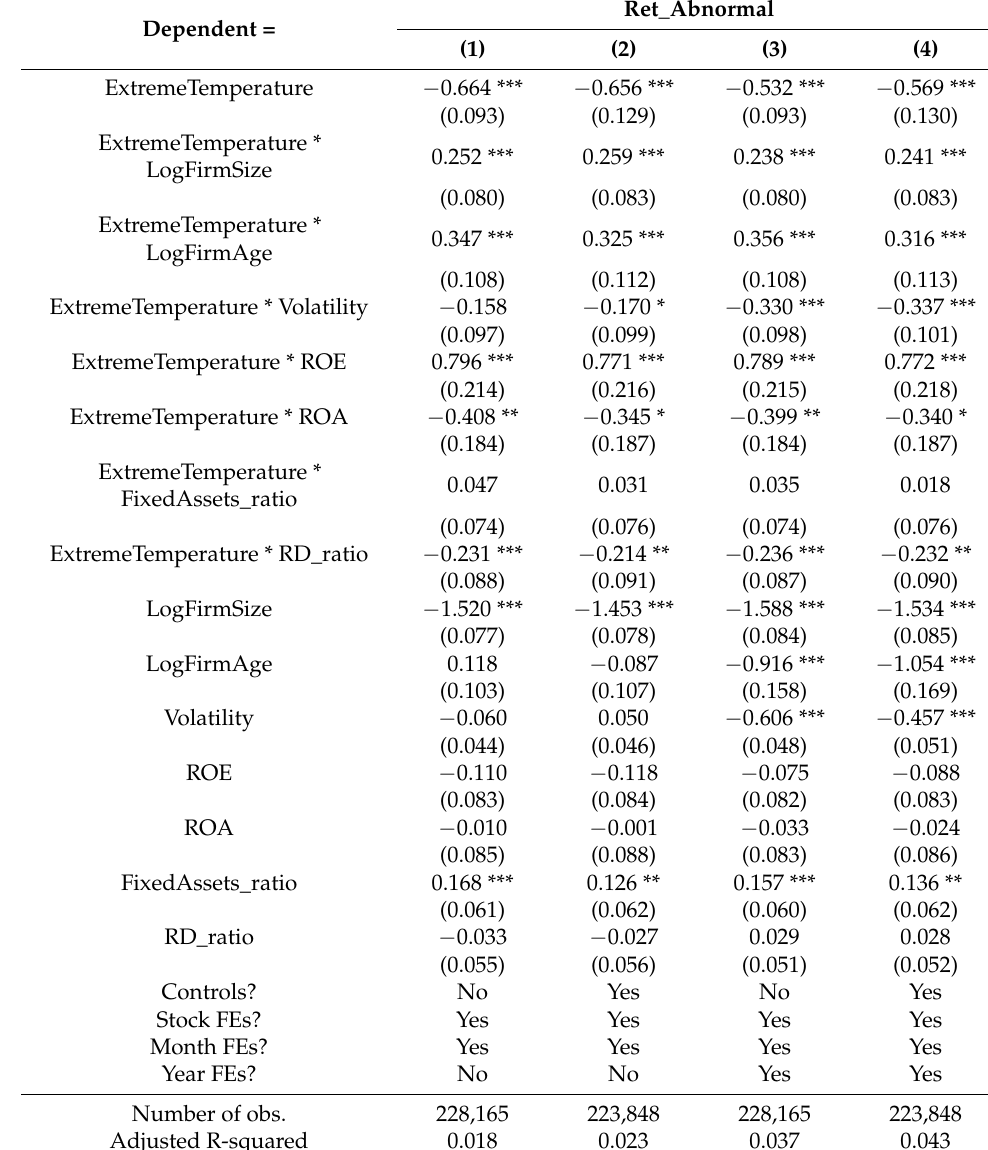
Table 7. Overarching regression models with the inclusion of all interaction